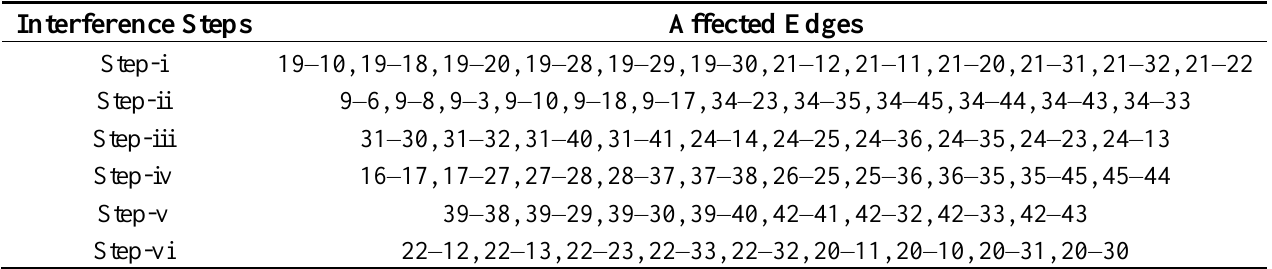
Table 4. Interference steps